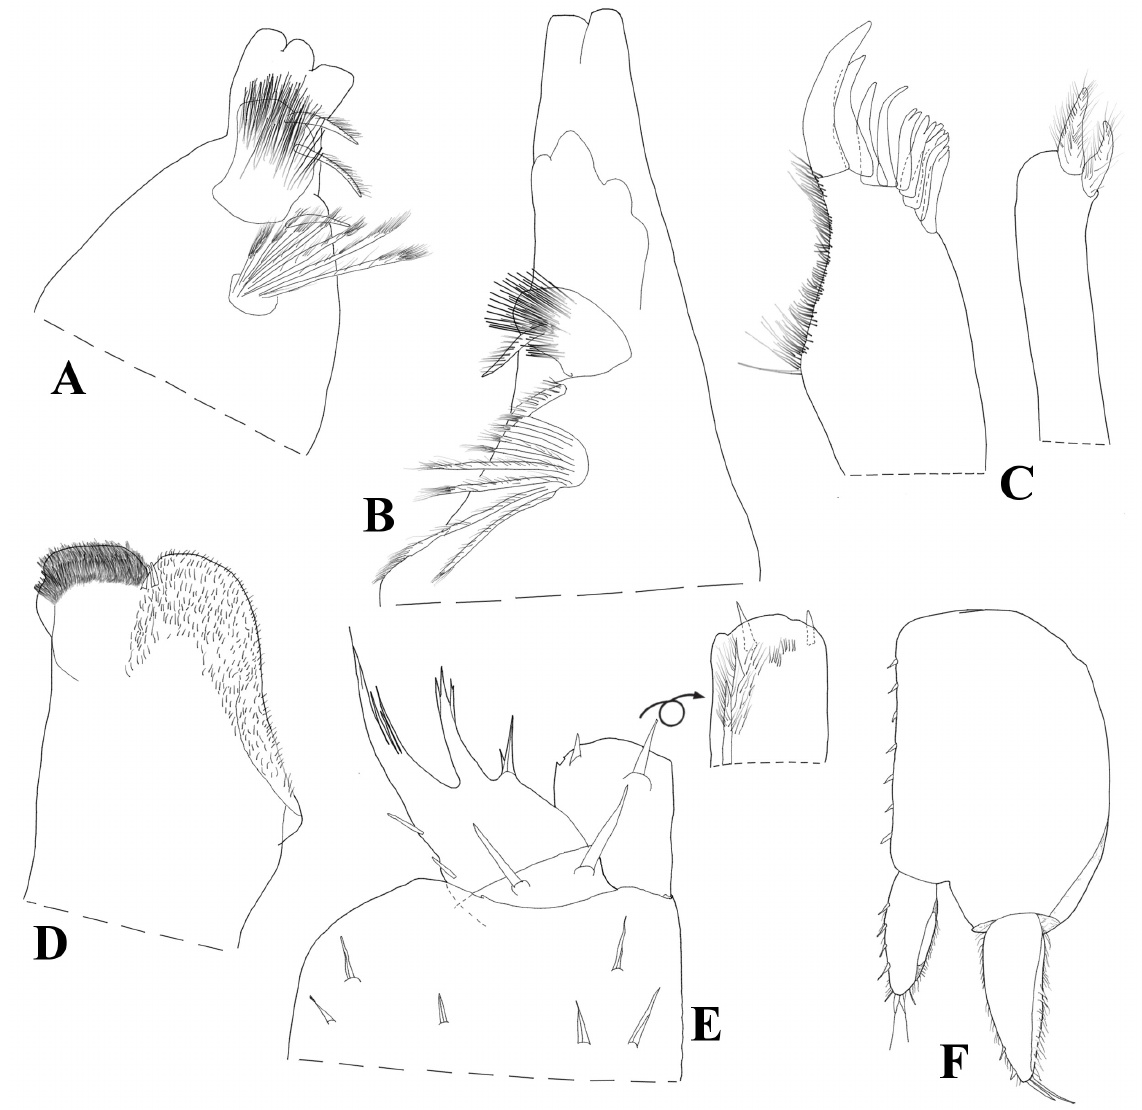
Fig. 2. Loretoniscus mashiriaensis gen. et sp. nov., ♂, holotype (MUSA-ENT-ISO 025). A . Left mandible. B . Right mandible. C . Maxillula. D . Maxilla. E . Maxilliped. F .